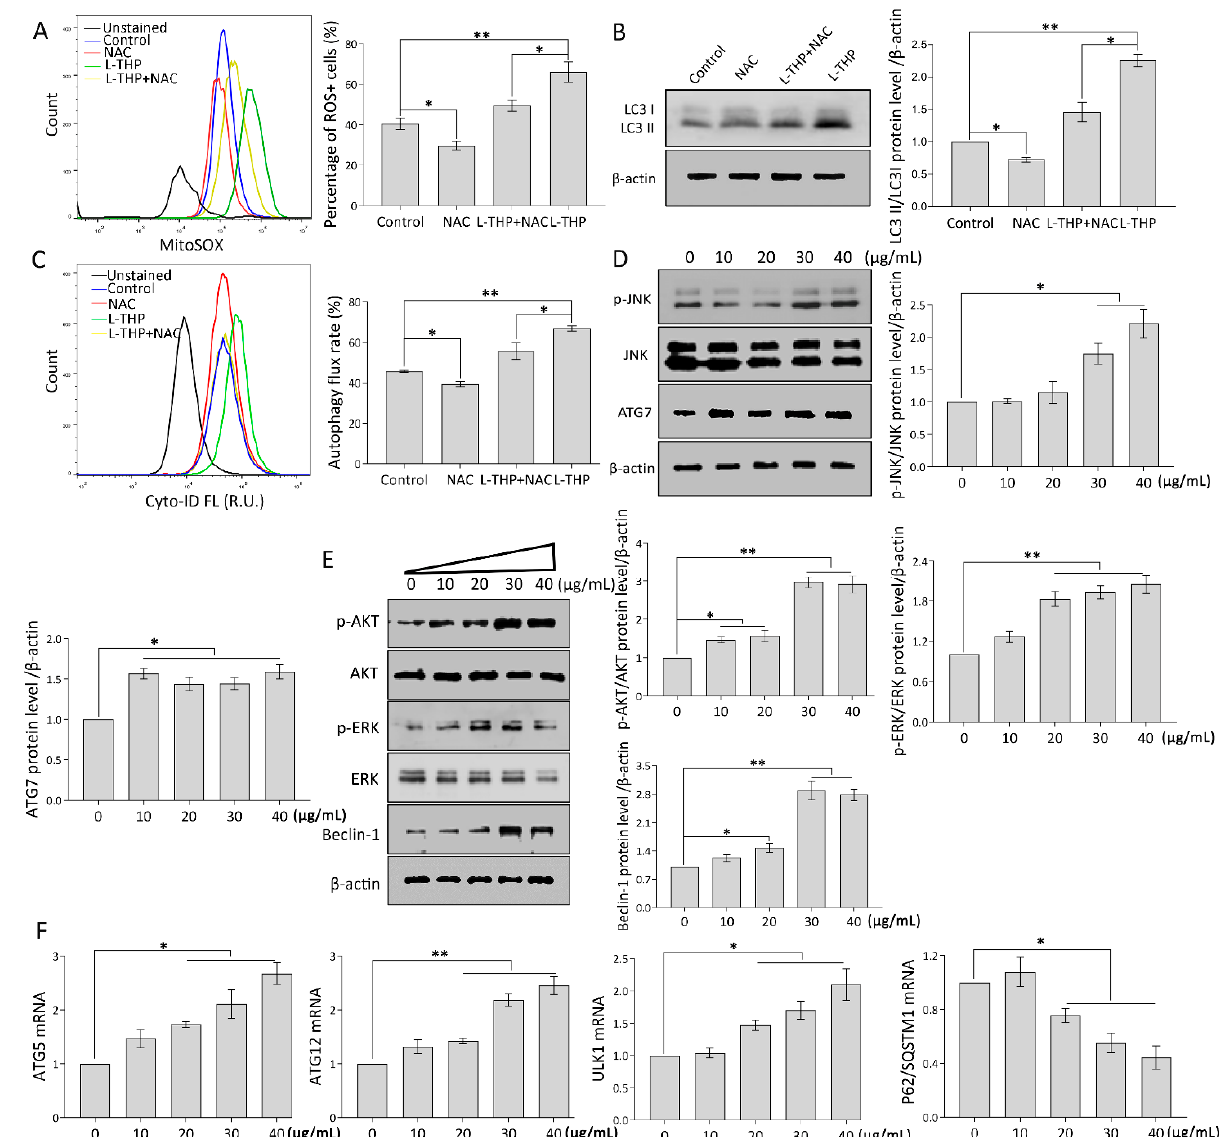
Figure 3. L-THP enhances autophagy flux via ROS-JNK-ATG axis. ( A ) L-THP induced mtROS accumulation in HepG2 cells treated with vehicle, 5 mM NAC, 40 µg/mL L-THP, or a combination of NAC and L-THP for 24 h. ( B ) LC3 level was evaluated by western blotting and ( C ) CYTO-ID dye signal was analyzed by flow cytometry. ( D ) p-JNK/JNK and ATG7 expression levels were evaluated. ( E ) p-ATK/AKT, p-ERK/ERK, and Beclin-1 were examined by western blotting. ( F ) mRNA expression of ULK1, ATG5, ATG12, and P62/SQSTM1 was detected using qPCR. Values are expressed as the mean ± SD of three independent experiments (n = 3). * p < 0.05 and ** p < 0.01 are considered to be statistically significant.